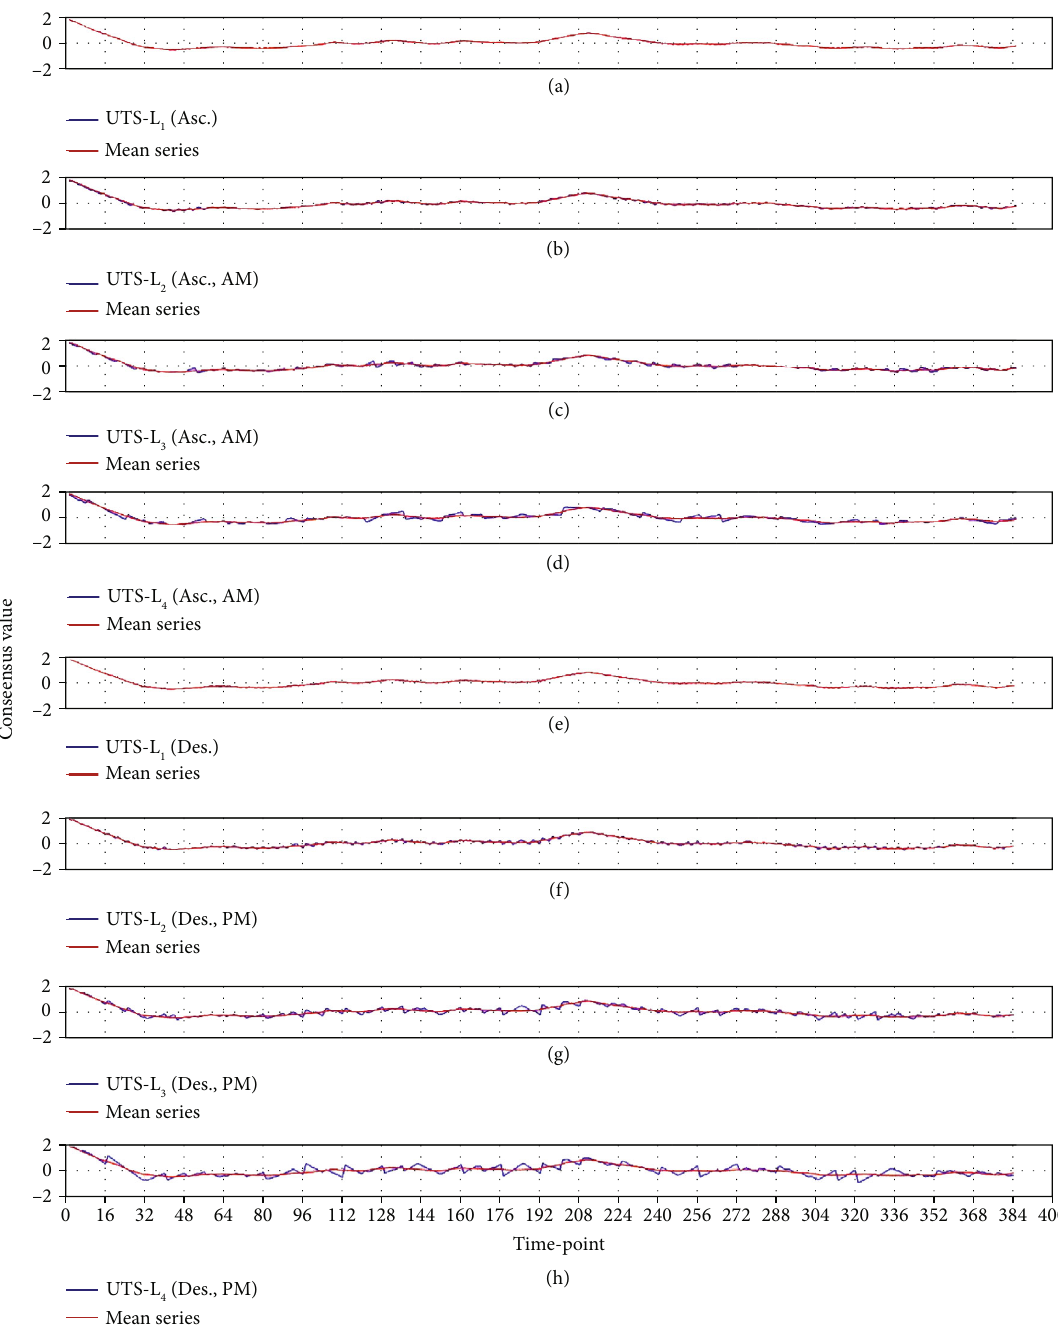
– UTS- L Figure 7: UTS- L : (a – d) ascending hierarchy with AM-inverse (Asc., AM) and (e – h) descending hierarchy with PM-inverse (Dec., 1 4 PM). Data track: OSULeaf